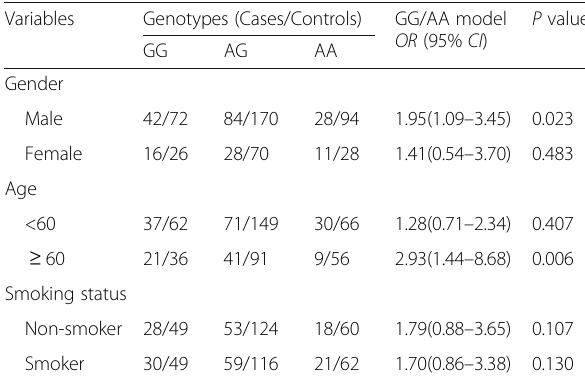
Table 2 Genotype frequencies of TNFSF15 polymorphisms and their association with SCLC